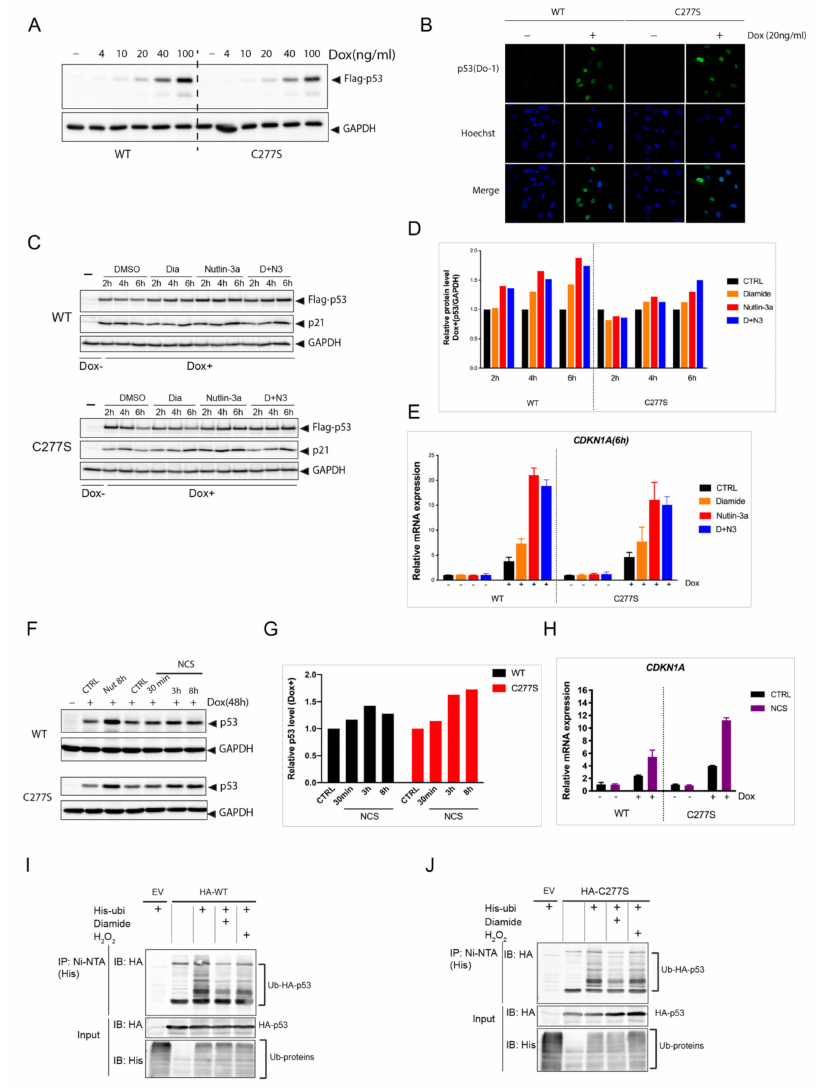
Figure 5. p53C277S is stabilized and activated similar to p53 WT in response to Nutlin-3a, oxidant treatment and DNA damage. ( A ) Dox-inducible expression of Flag-p53 WT and C277S in p53 KO RPE Tert cells upon titration with doxycycline. ( B ) Immunofluorescence images showing the sub- cellular localization of Flag-p53 WT and C277S in dox-inducible p53 KO RPE Tert cells. Both are mainly localized in the nucleus. ( C ) Flag-p53 level in dox-inducible expressing p53 WT and p53C277S RPE Tert cells upon different stimuli. Flag-p53 WT and C277S were induced by Dox (20ng/ml, 48h) in p53 KO RPE Tert cells, followed by treatment with diamide (200 µ M), Nutlin-3a (10 µ M), or both (D+N3) for the indicated time. Total cell lysate was harvested and the levels of Flag-p53 WT, C277S, p21 and GAPDH (as a loading control) were evaluated. The blots are representative for the results of at least three independent experiments. ( D ) Quantification of Flag-p53 WT and C277S protein levels relative to GAPDH from (C). ( E ) CDKN1A (p21) mRNA expression in Dox-inducible expressing p53 WT and C277S RPE Tert cells upon different treatments as determined by qPCR. ( F ) Flag-p53 level in the Dox-inducible expressing p53 WT and C277S RPE Tert cells upon Neocarzinostatin (NCS)(250 ng/ml) or Nutlin-3 treatment. ( G ) Quantification of Flag-p53 WT and C277S protein levels relative to GAPDH from (F). ( H ) CDKN1A (p21) mRNA expression in Dox-inducible expressing p53 WT and C277S RPE Tert cells upon NCS treatment as determined by qPCR. Ubiquitination of p53 WT ( I ) and C277S ( J ) upon diamide or H 2 O 2 treatment. HEK293T cells transiently expressing